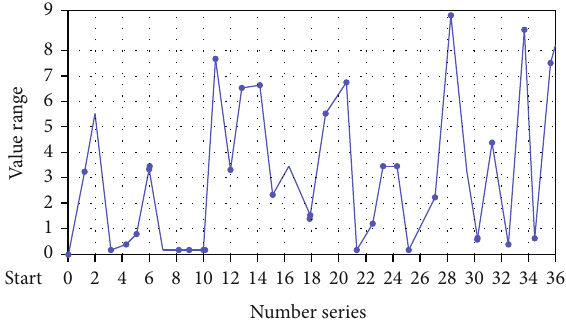
Figure 9: Parameter optimization range of the new optimization